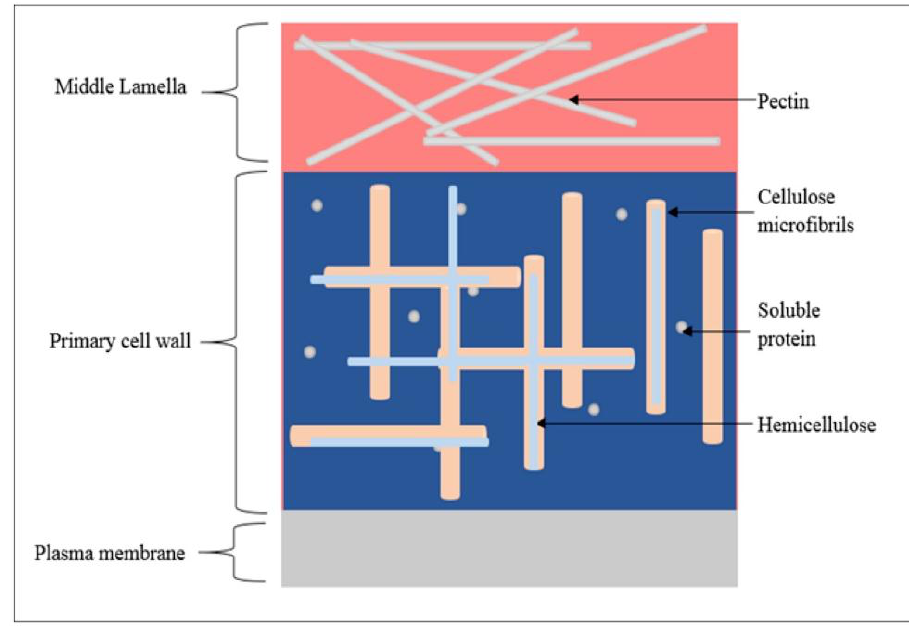
Figure 1. Basic plant cell wall structure.